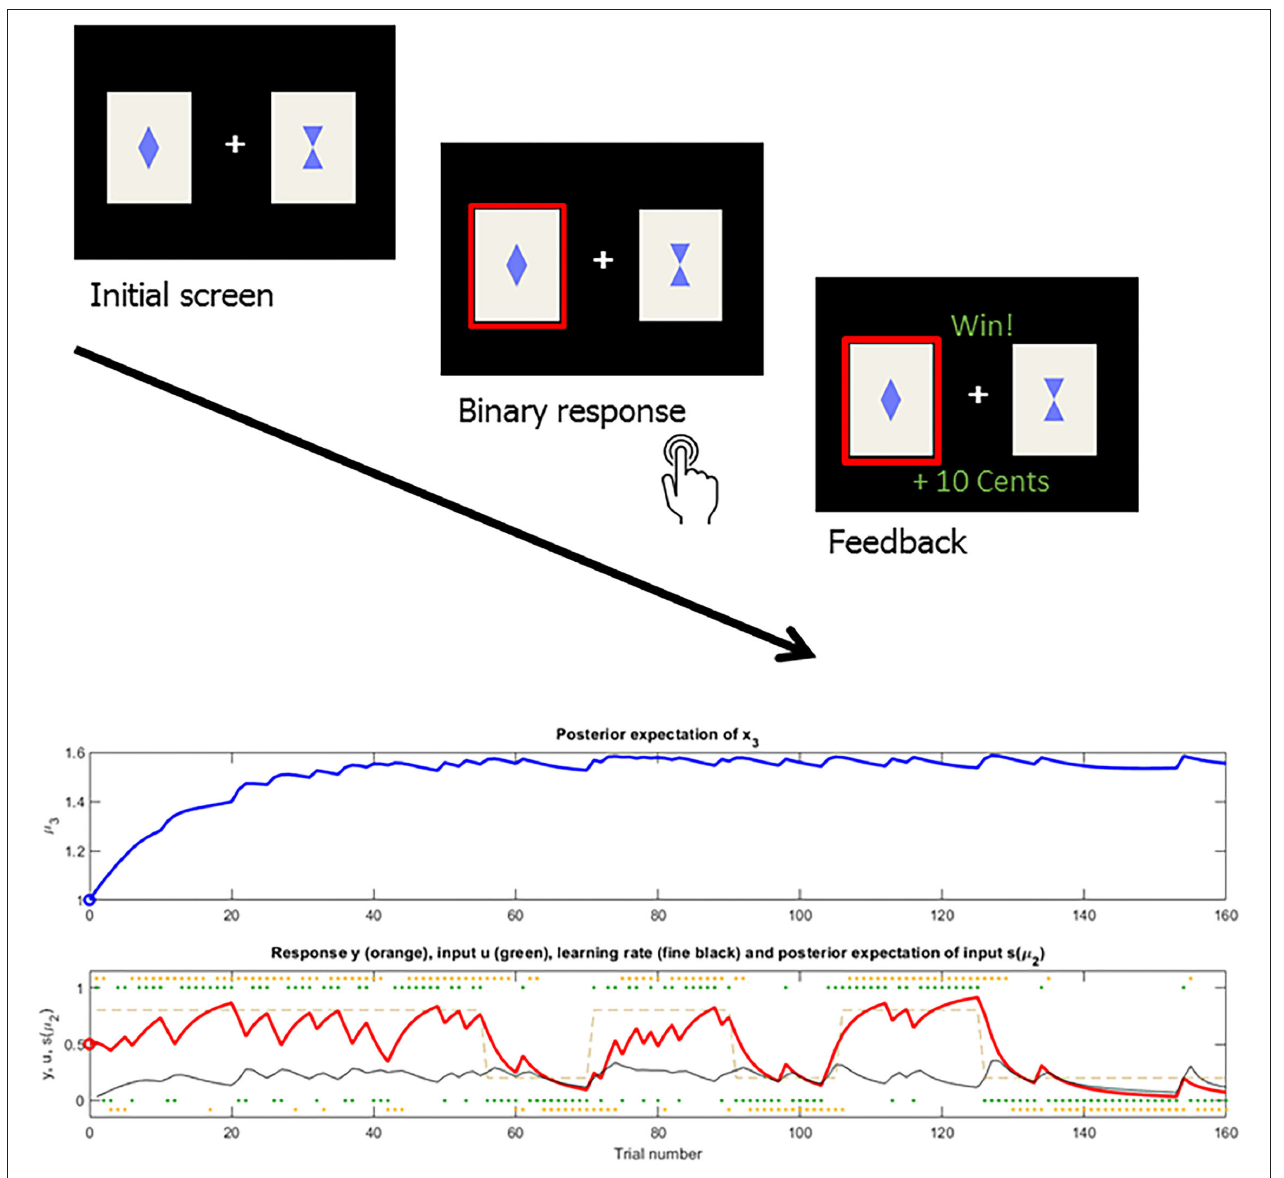
FIGURE 1 | Reversal learning task example and the associated HGF learning trajectories fitted to binary choice data of an individual participant. Upper plot: Depiction of trial sequence in a volatile reversal learning task with geometric stimuli (rewarded in this trial) [as in (22)]. Participants had to make a binary choice between one out of two stimuli via a button press and were presented with either a reward or loss outcome. Lower plot: Upper panel: Blue line represents one subject’s individual trajectory of higher-level belief µ 3 over the course of the task from trial 1–160. Lower panel: Underlying contingencies are depicted in light brown with anti-correlated reward probabilities of one of the stimuli, reward contingencies remain stable in the beginning and end of the task with a volatile reversal period in between. Red line represents the belief µ 2 and reflects the tendency x 2 (or probabilistic strength) of stimulus A leading to reward. Black line represents the dynamic learning rate on the second level belief µ 2